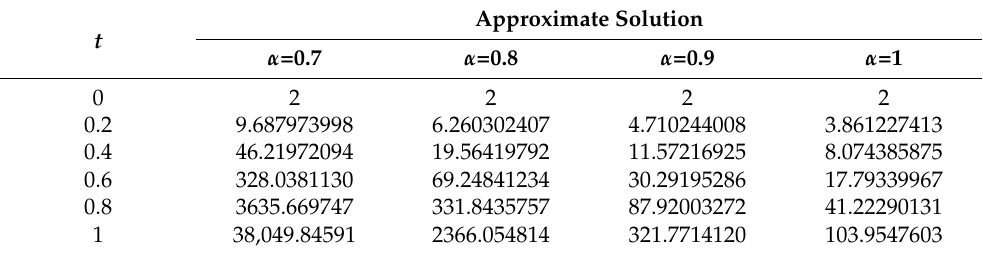
Figure 3. The exact solution Equation (28) (green line) coincides with the approximate solution using the ADM-Kamal Combined Theorem for parameter α = 1 (black dot). Table 1. The exact solution for the economic growth model using ADM-Kamal Combined Theorem for α = 0.7; 0.8; 0.9; and